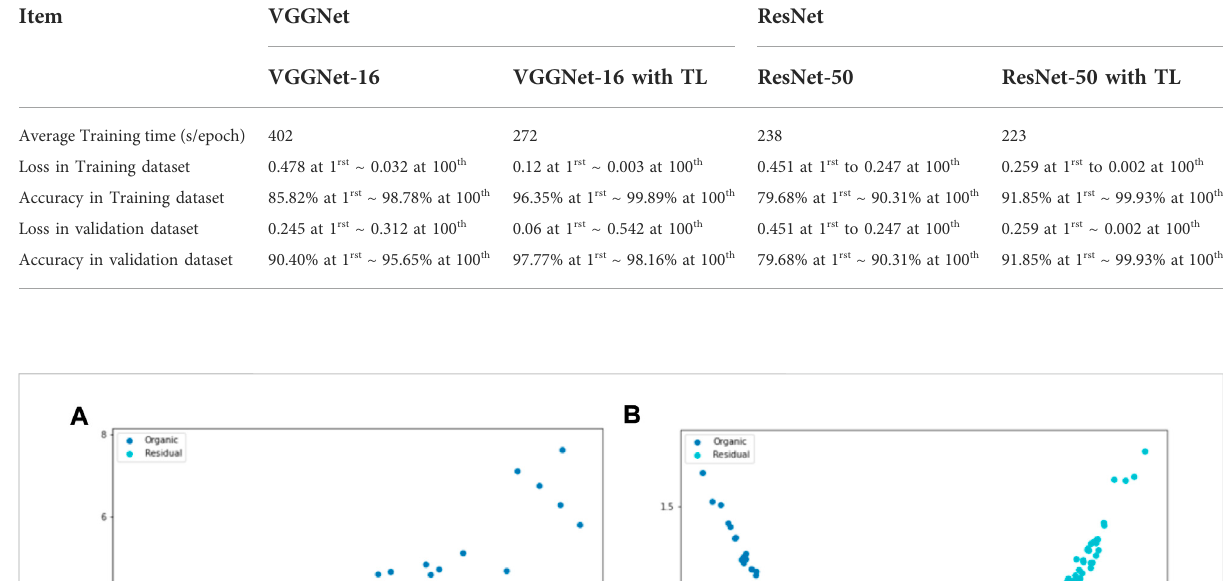
TABLE 2 Effect of transfer learning on the performance of VGGNet-16 and ResNet-50 in the training dataset and validation dataset.